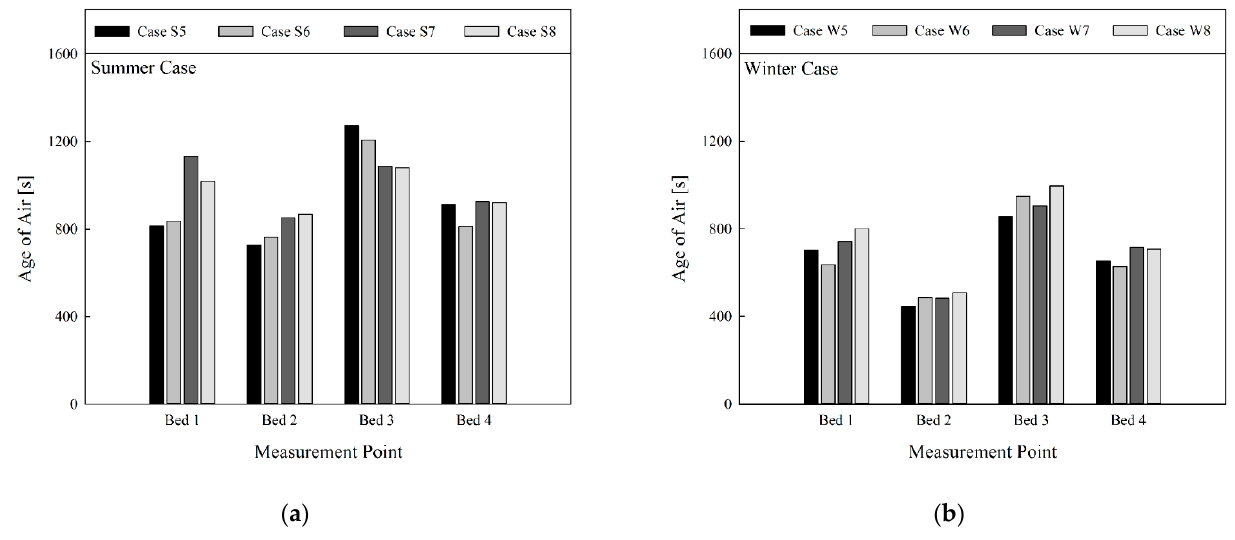
Figure 7. Comparison of age of air at bed location by season (in cases of ventilation system operation, four-way cassette fan coil unit operation, non-operation of air cleaner, and use of curtain): ( a ) summer; ( b ) winter.